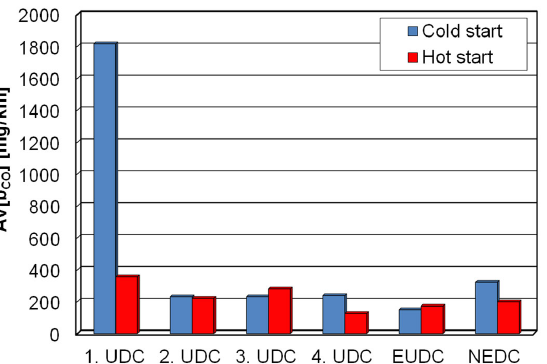
Figure 10. Average carbon monoxide emissions (AV[b CO ]) in four parts as well as in the NEDC test for cold and hot starts.